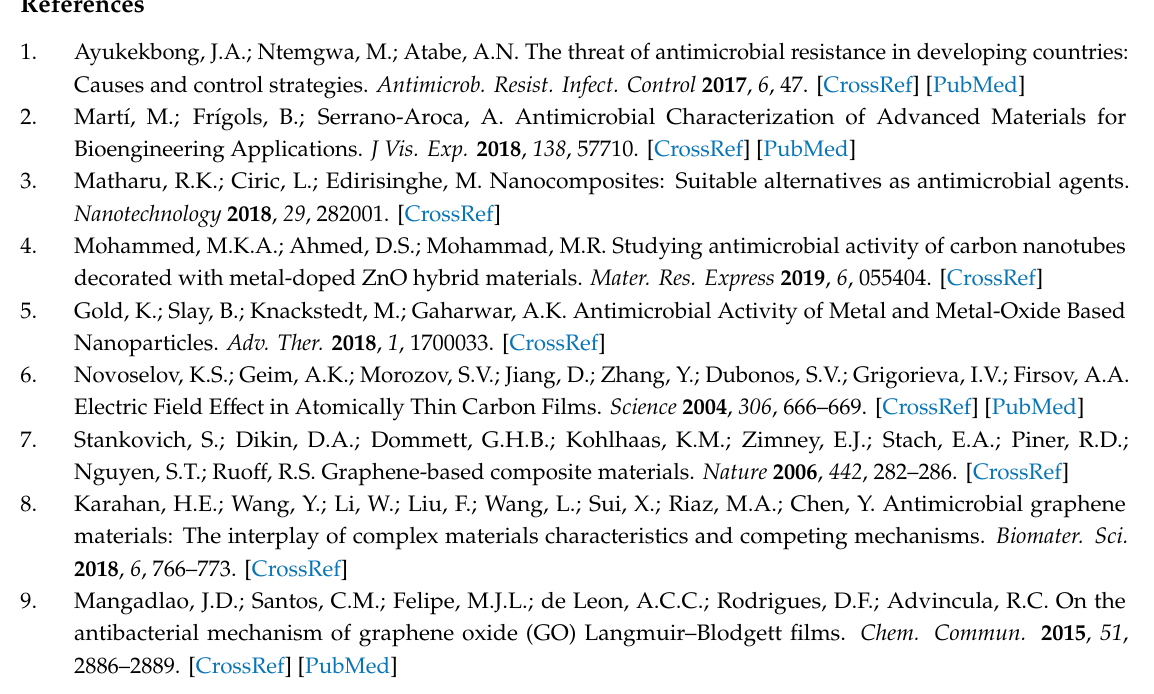
Figure S1: FTIR (a) and XRD (b) analysis of GO, Figure S2: FTIR (a) and XRD (b) analysis of GO–Ag NPs, Figure S3. Antibacterial activities of GO during 13 h observation (a) and GO–Ag NPs (b) during 4 h